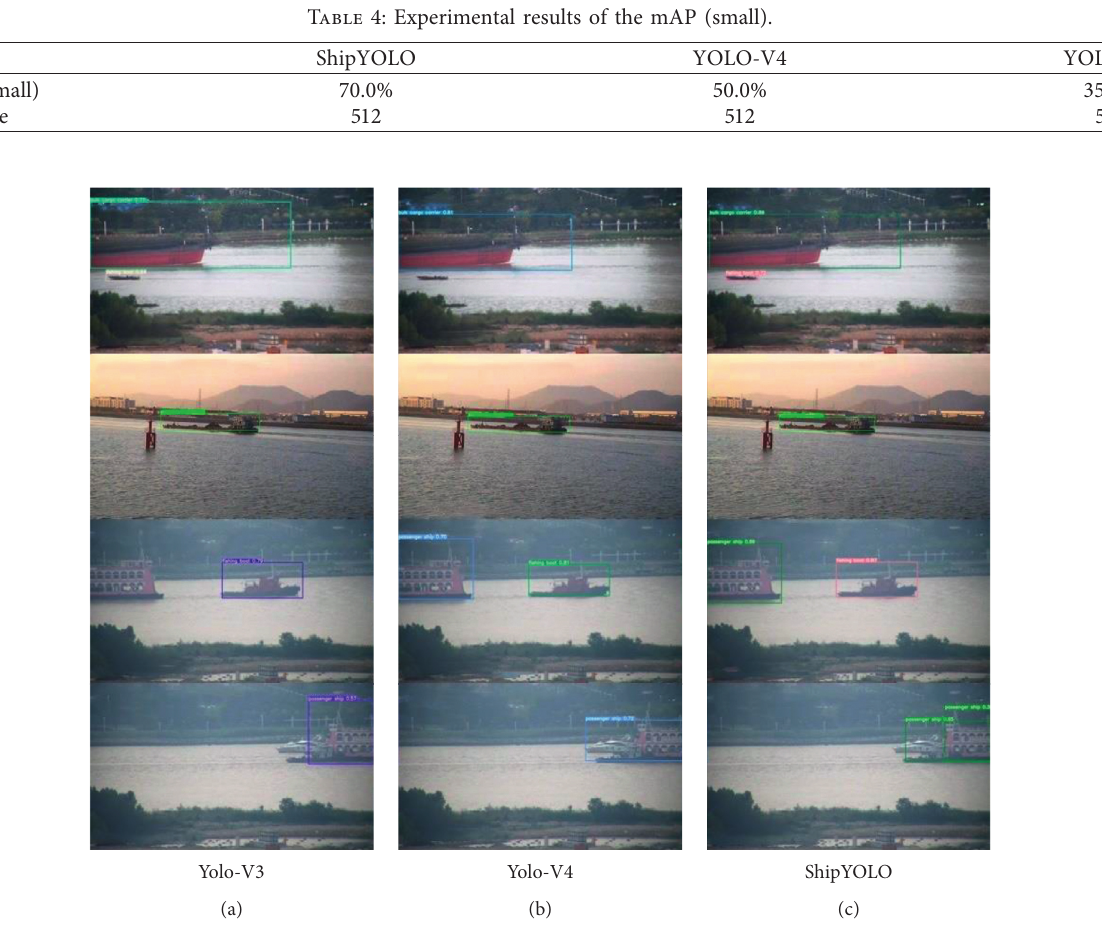
Figure 10: Validation result of the seaships.